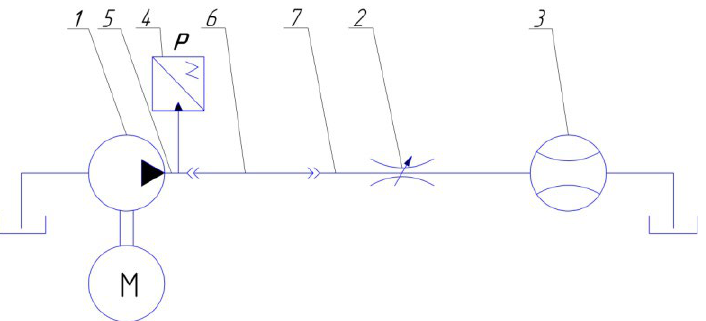
Figure 9. ISO 1219 scheme of the bench system implementing an active load impedance at the liquid output from the pump: 1—pump, 2—load throttle, 3—flow sensor, 4—liquid pressure sensor, 5 and 7—connecting fittings and 6—line.